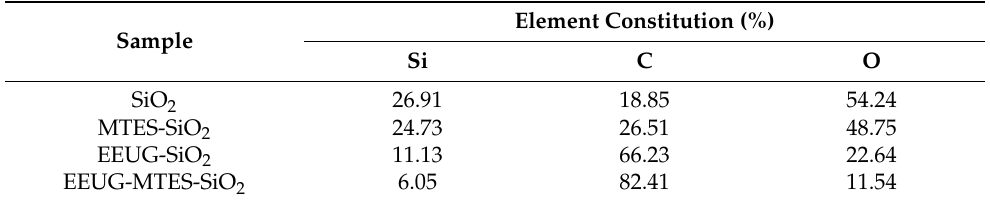
Figure 3. XPS wide-scan spectra of SiO 2 , MTES-SiO 2 , EEUG-SiO 2 , and EEUG-MTES-SiO 2. Table 2. Comparison of atomic content (at.%) in the XPS spectra of SiO 2 , MTES-SiO 2 , EEUG-SiO 2 , and EEUG-MTES-SiO 2 .